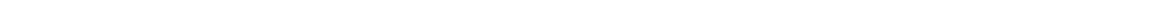
Fig. 7 Transcriptome analysis upon transient CD271 overexpression. a RNAseq of cells before, during and after CD271 transient overexpression was performed and analyzed using edgeR. Genes were fi ltered for Log2 ≥ +0.27 and ≤ − 0.27, p -value < 0.05, FDR < 0.05, which resulted in 160 genes signi fi cantly upregulated upon CD271 overexpression (comparing CMVTOCD271 + DOX 24 h over CMVTOCD271 – DOX24 h) with subsequent signi fi cant downregulation (comparing CMVTOCD271 + DOX 24 h/ − DOX 48 h over CMVTOCD271 + DOX 24 h) and vice versa in 303 genes signi fi cantly downregulated upon CD271 overexpression with subsequent signi fi cant upregulation. Heatmap represents row z-scores of normalized counts from RNAseq. b Top 20 gene ontology process enrichments from MetaCore TM . Numbers in brackets indicate the number of differentially expressed genes above the total number of genes within an annotated pathway. c Selected “ switching ” genes from a involved in cholesterol and lipid biosynthesis pathways. Again, heatmap represents row z-scores of normalized counts from RNA Seq. d Survival curves based on TCGA data for expression of cholesterol biosynthesis genes in human melanoma samples. Data from 114 patients per condition were analyzed, which represent 25% of highest and lowest expressing patients. e Selected “ switching ” genes from a involved in cell cycle regulation. Again, heatmap represents row z-scores of normalized counts from RNA Seq. f qRT-PCR for cell cycle genes in ICD overexpressing and EV melanoma cells. g qRT-PCR for cholesterol and lipid biosynthesis genes in ICD overexpressing and EV melanoma cells. For f and g , n = 3 for each condition. P values > 0.05 = n.s., P values ≤ 0.05 = *, P values ≤ 0.01 = **, P values ≤ 0.001 = ***. Error bars for f and g indicate S.D. All experiments done with cell line